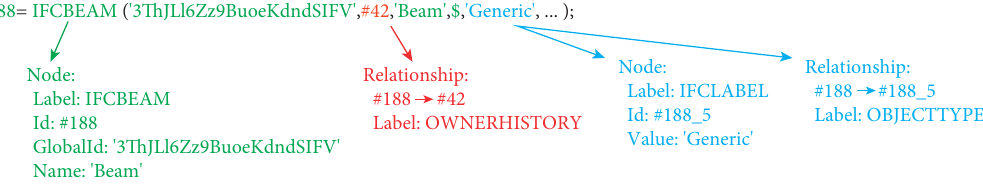
Figure 7: Python dictionary of class IfcBeam with its attribute key-value pairs.